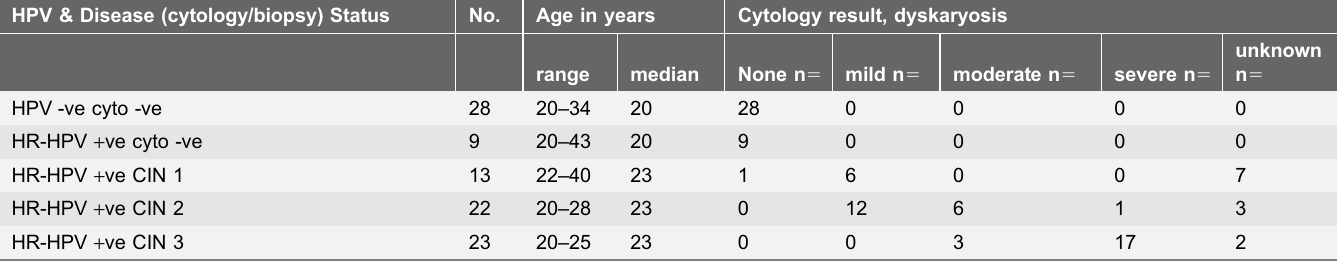
Table 1. Disease status, age range and cytology results for cervical LBC samples obtained from the Scottish national HPV Archive. HPV & Disease (cytology/biopsy)